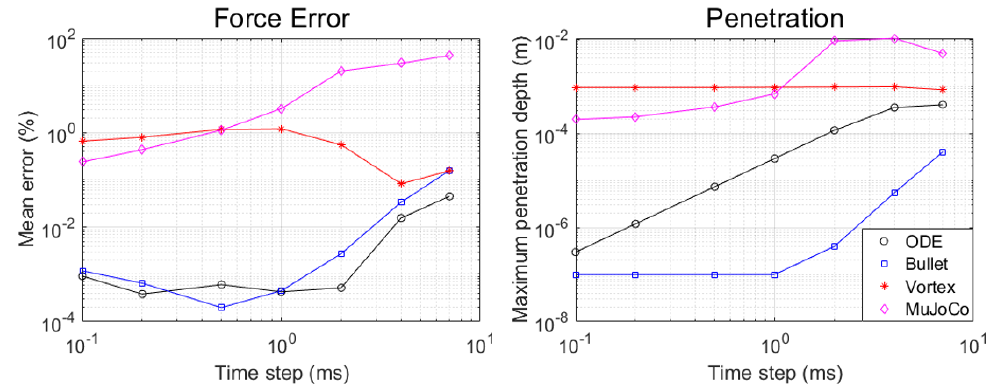
Figure 5. Performance of each physics engine for a simple scenario: ( left ) average percentage error of the friction force acting on all upper boxes with an analytic solution; ( right ) maximal penetration depth of all upper